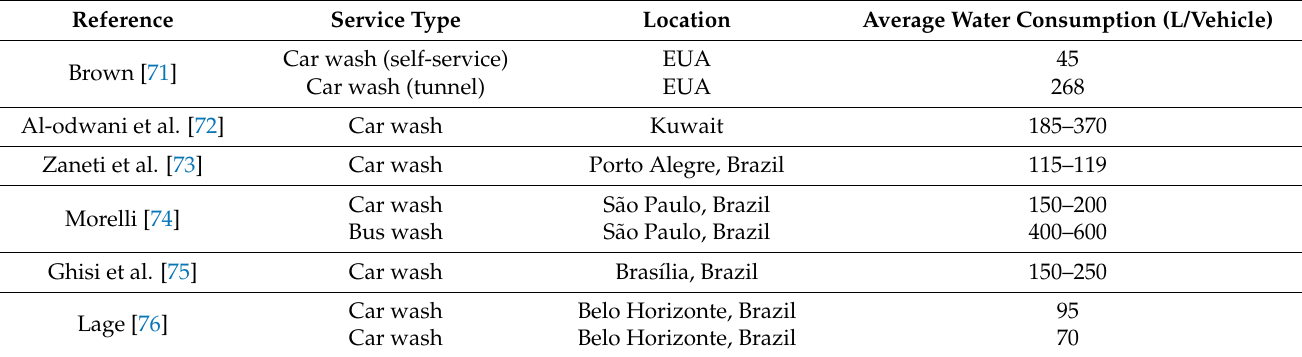
Table 2. Water consumption for washing vehicles in different